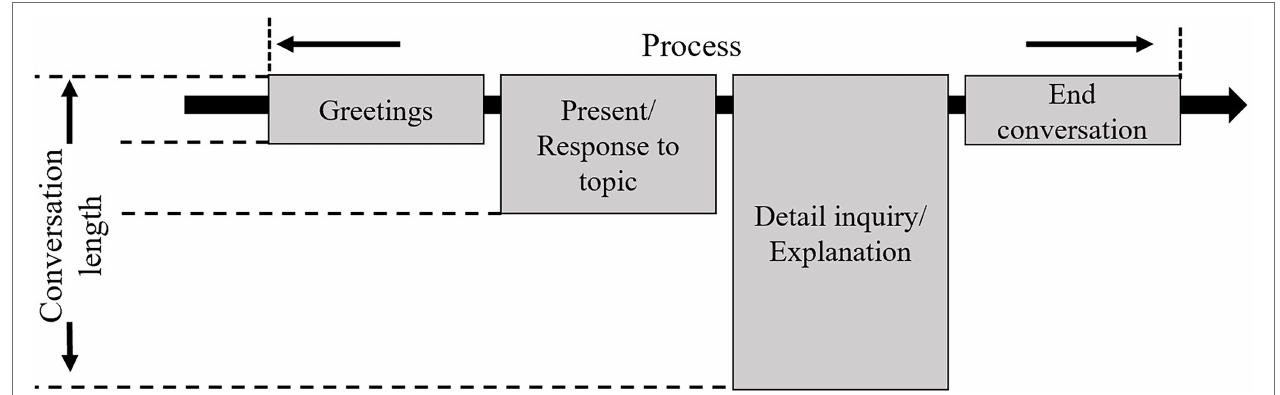
FIGURE 1 | Dialog